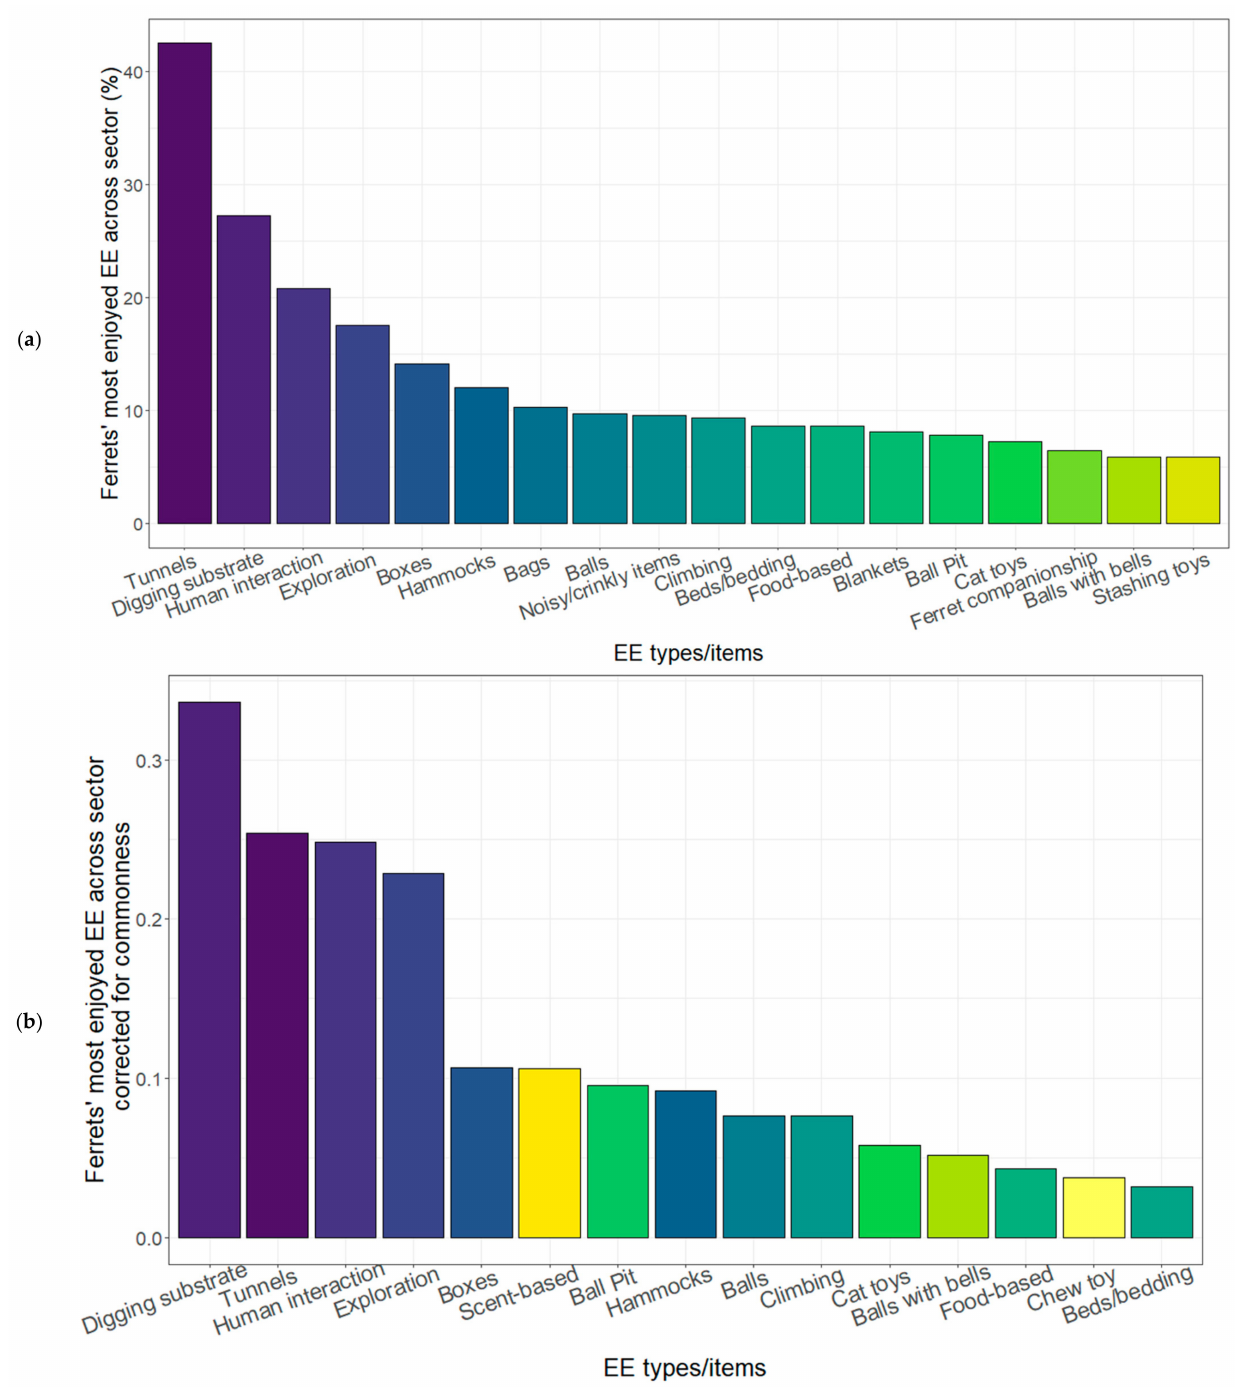
Figure 4. Caretakers’ opinions of ferrets’ most enjoyed EE types. In ( a ), the data are organised in decreasing order of the raw percentage of respondents suggesting the EE most enjoyed by their ferrets. Only the EE types that were reported by ≥ 5% of respondents are shown. In ( b ), caretakers’ opinions of ferrets’ most enjoyed EE types when corrected for commonness of provision of EE type are shown. Only EE types listed in the multiple-choice list for question ‘which EE types do you offer your ferret’ could be corrected for commonness. For both ( a , b ), the purple to yellow colour gradation indicates most to fewer absolute numbers of respondents reporting the EE to be enjoyed. EE types suggested by fewer than 5% of respondents as ferrets most enjoyed EE types, and therefore not shown, were water (4.9%), soft toys (4.8%), toys on a string/stick (4.5%), dog toys (2.5%), scent-based EE (1.8%), shoes (1.8%), socks (1.5%), grass (1.4%), chew toys (1.4%) and rocks/logs